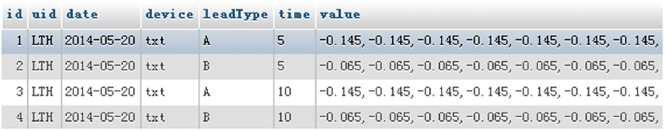
MySQL database storage method II storing 5 minutes of ECG data in a record.